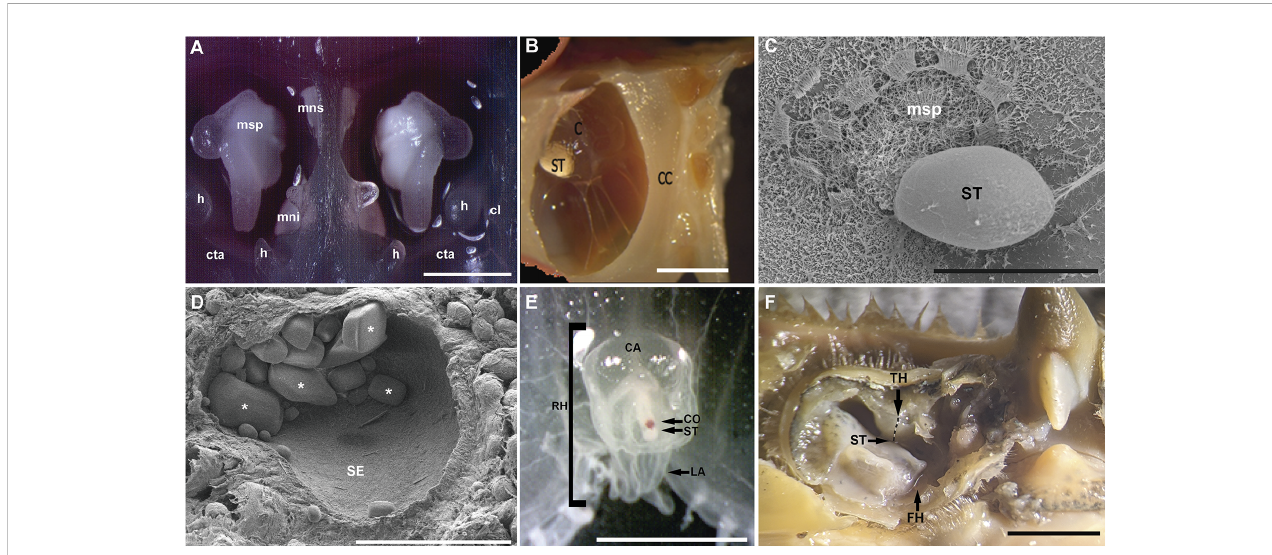
FIGURE 6 Invertebrate marine statocyst ( A – C : Cephalopods. D : Gastropods. E : Cnidarians. F : Crustaceans). (A,B, E, F) : Photomicrograps . (C, D): SEM. (A) : epia of fi cinalis statocyst cavities opened transversally (Anterior view). Each cavity shows the three macula-statolith systems (msp, mns, mni) and two of the crista-cupula systems (cta, cl)(Sole ́ et al., 2017). (B) : Lateral view of the interior of a Octopus vulgaris statocyst. The spherical inner sac is suspended in the cephalic cartilage cavity by fi brous strands. The statolith is attached to the macula. The crista lies on the inside wall of the sac-like structure (Andre ́ et al., 2011). (C) : Illex coindetii hatchling inner statocyst morphology. The transversally opened statocyst cavity shows the statolith attached to the macula statica princeps. Note the hair cell kinociliary groups arranged in nearly concentric rings around a center (Sole ́ et al., 2018). (D) : Inner cavity of apple snail ( Pomacea maculate) statocyst covered by sensory epithelium. Some aragonite crystals are visible (asterisk) (Sole ́ et al., 2021a). (E) : Anterior view of the jelly fi sh Aurelia aurita rhopalium bell margin. There is a mass of sensory cells with a single layer of pigment cells (pigment-cup ocellus) on the oral side near the statocyst (Sole ́ et al., 2016). (F) : Transversally opened statocyst cavity of a blue crab ( Callinectes sapidus ). Arrows point to the location of the different ciliary areas (ST, TH, FH). TH hair cells run following a line distribution as it is shown in the image (Sole ́ et al., 2023) (ca, rhopalar canal; C, Crista; CC, Cephalic cartilage; cl, crista longitudinalis; co, pigment-cup ocellus; cta, crista transversalis anterior; FH, Free-hook hairs; h, hamuli lobe; LA, lappet; mni, macula neglecta inferior; mns, macula neglecta superior; msp, macula statica princeps; RH, rhopalium; SE, Sensory epithelium; ST, statolith; TH, Thread hairs). Scale bars: (A, B) = 2 mm. (F) = 0,5 mm. (E) = 400 m m. (D) = 200 µm. (C) = 20